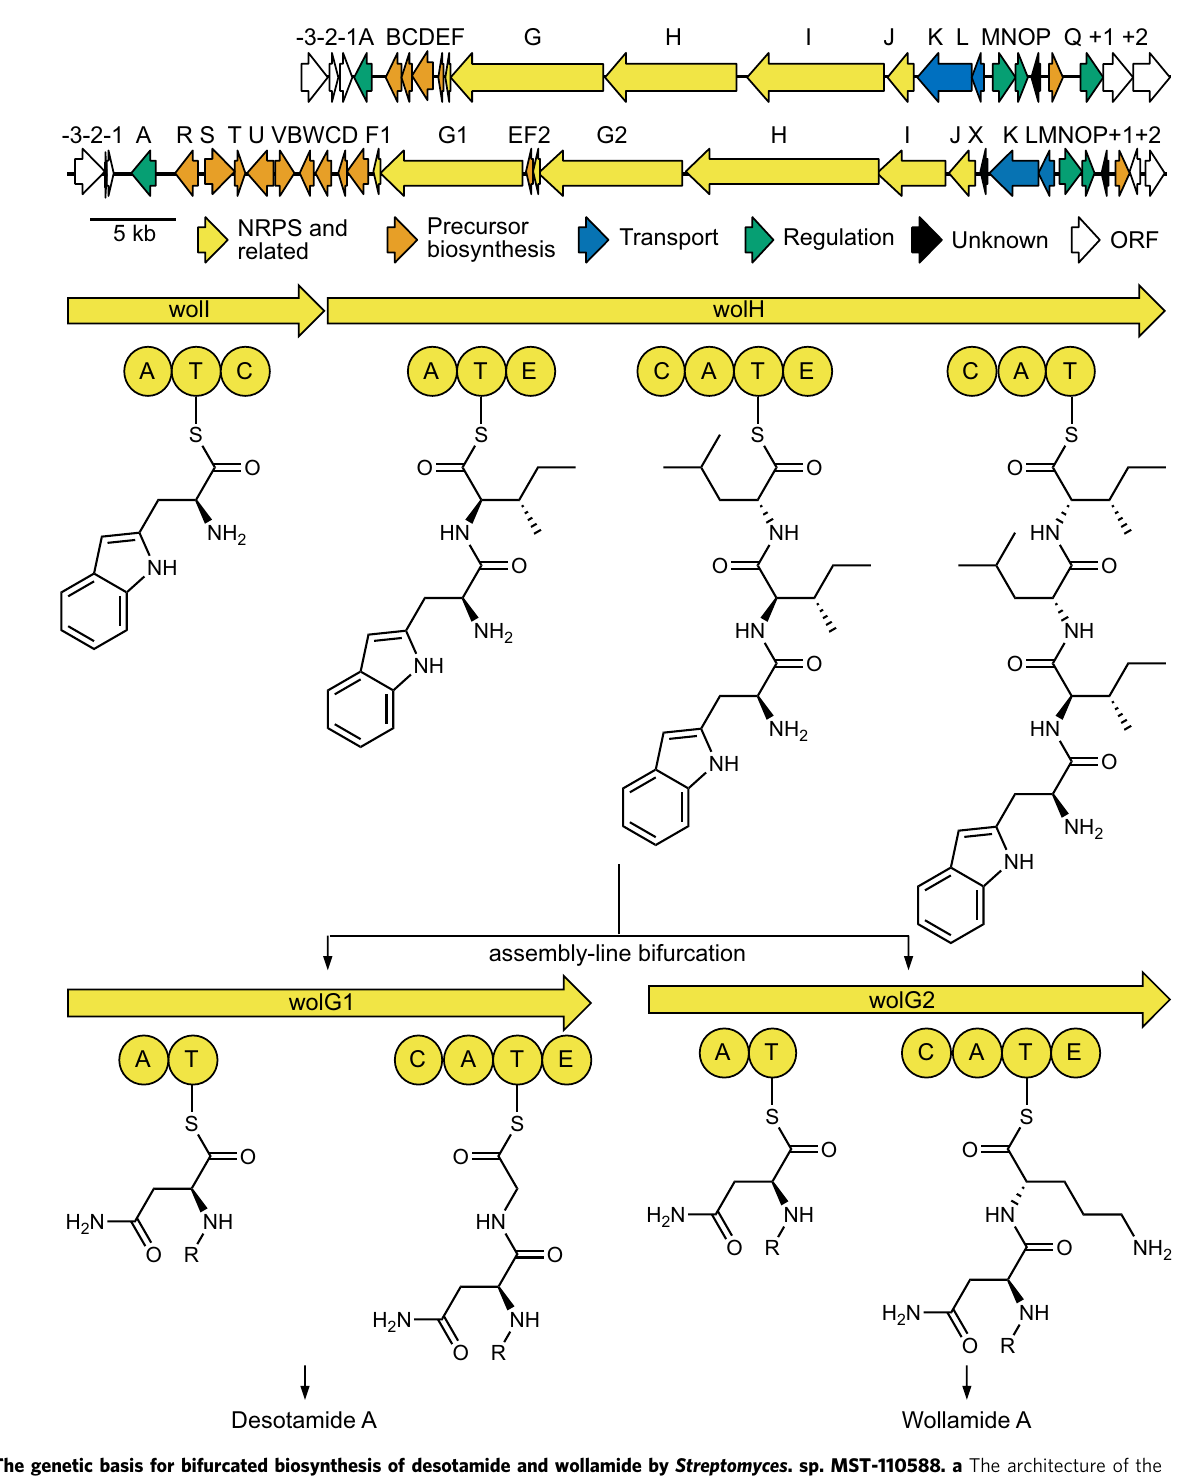
Fig. 2 The genetic basis for bifurcated biosynthesis of desotamide and wollamide by Streptomyces . sp. MST-110588. a The architecture of the desotamide producing dsa BGC from Streptomyces scopuliridis SCSIO ZJ46 25 . b The architecture of the wollamide and desotamide producing wol BGC from Streptomyces sp. MST110588. c The proposed biosynthetic pathway of the wollamides and desotamides. The fi rst three condensations are catalysed by WolI and WolH. The fi nal two condensations are catalysed by WolG1 to produce desotamides or WolG2 to produce